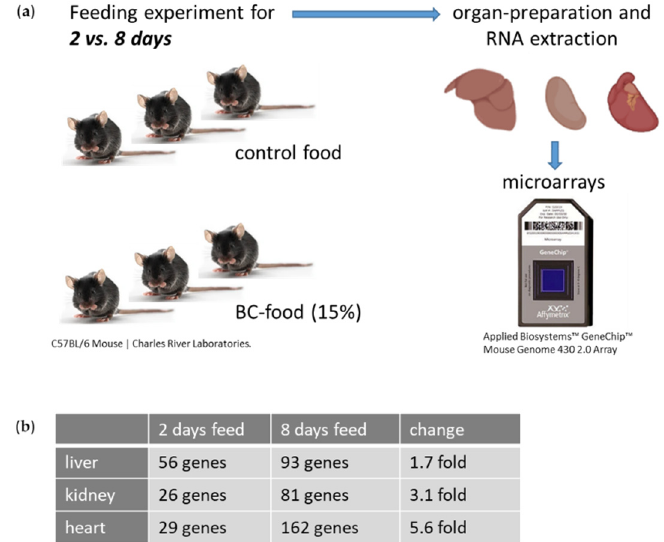
Figure 2. Experimental setup. ( a ) Three animals per food group (control- or BC-fed) were fed for 2 vs. 8 days. Kidney, heart and liver were prepared and after RNA Isolation microarray analyses were performed. ( b ) Overview of differentially expressed genes, which were identified through fold change (up-regulated > 2.0; down-regulated < − 2.0) as well as p -value < 0.05 (TAC 4.0; applied biosystems; Thermo Fisher Scientific, Waltham, MA, USA). Parts of the figure were created with BioRender.com.